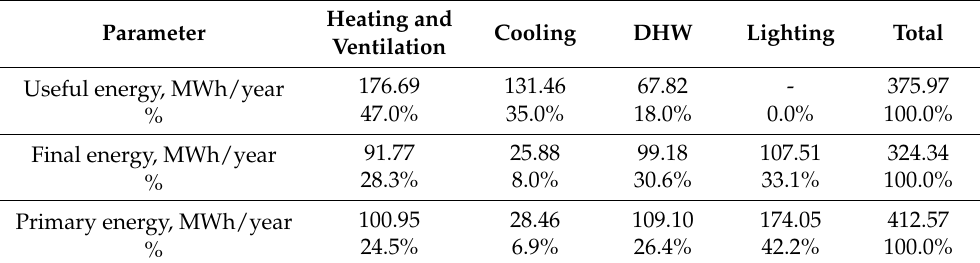
Table 11. Heat demand calculations after all retrofit activities—variant 3.